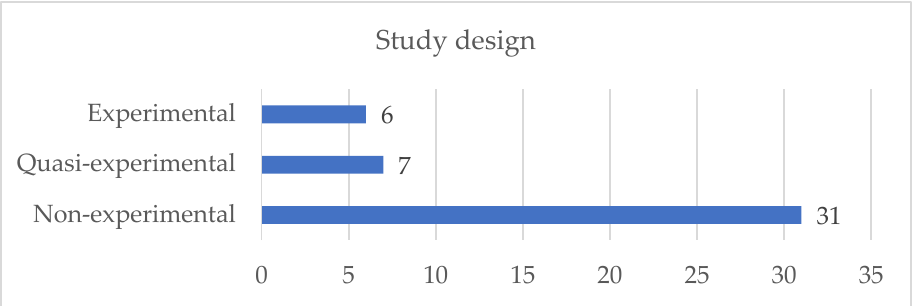
Figure 9. Study design of the reviewed empirical studies.